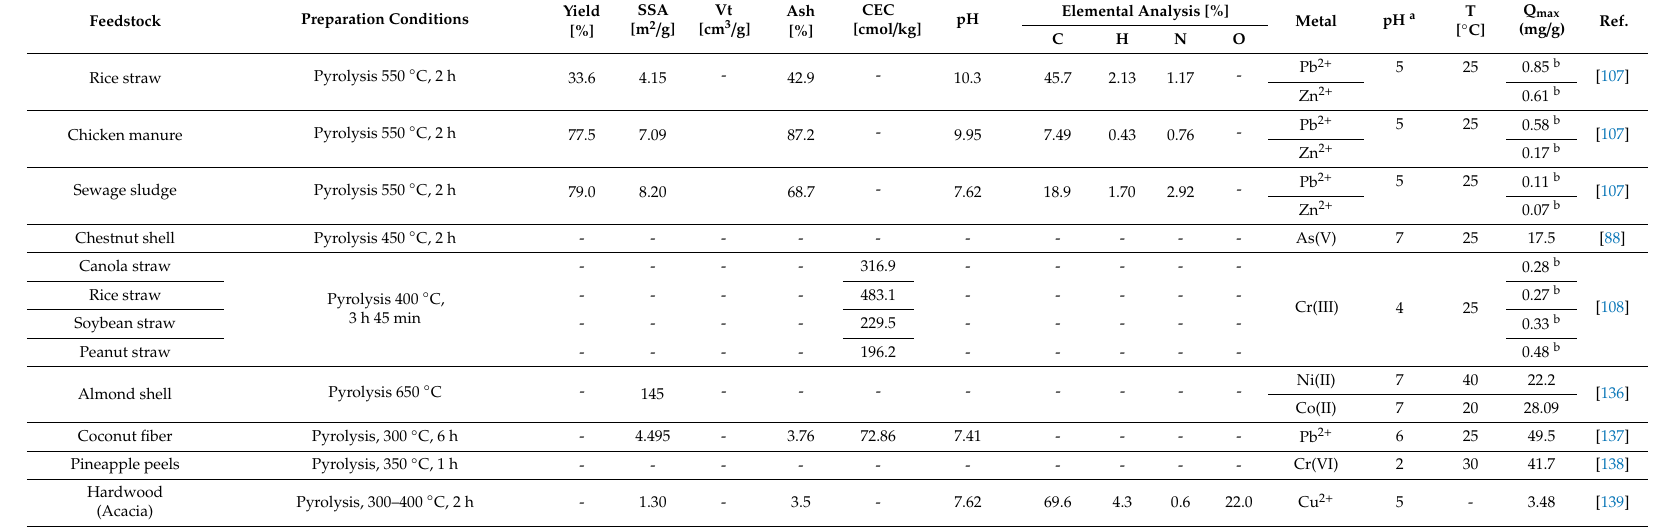
Table 3. Physico-chemical properties of various chars produced from di ff erent feedstock and by di ff erent thermal conversion methods for heavy metals removal.